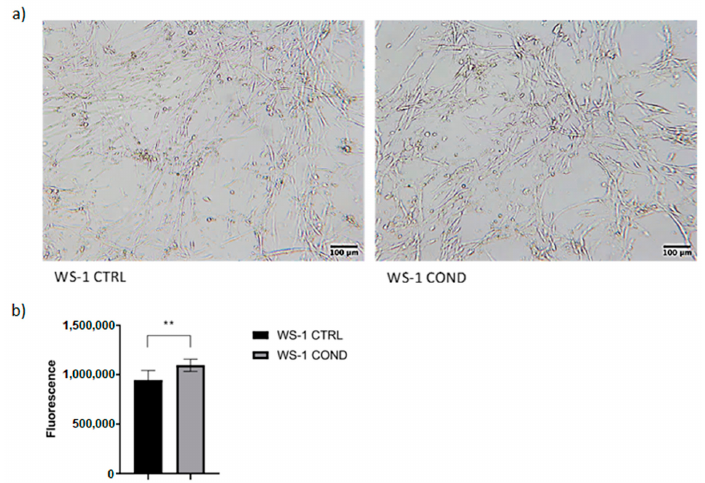
Figure 1. ( a ) Optical microscopy of WS-1 CTRL and WS-1 COND at 48 h after cell seeding (4× (4 × magnification). ( b ) WS-1 CTRL and WS-1 COND viability measured at 24 h with magnification). ( b ) WS-1 CTRL and WS-1 COND viability measured at 24 h with PrestoBlue assay. ** p < 0.01